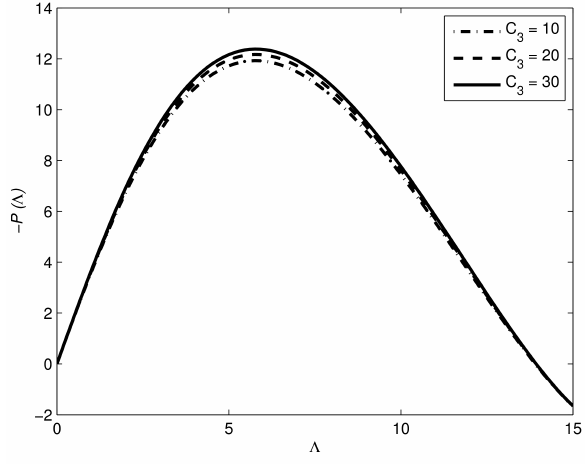
Figure 11: Effect of ζ on − H ( Λ ) keeping η = 0.2 , C 1 = C 2 = C 3 = 50 , Pr = 6.8 , Br = 1 and Re = 2950